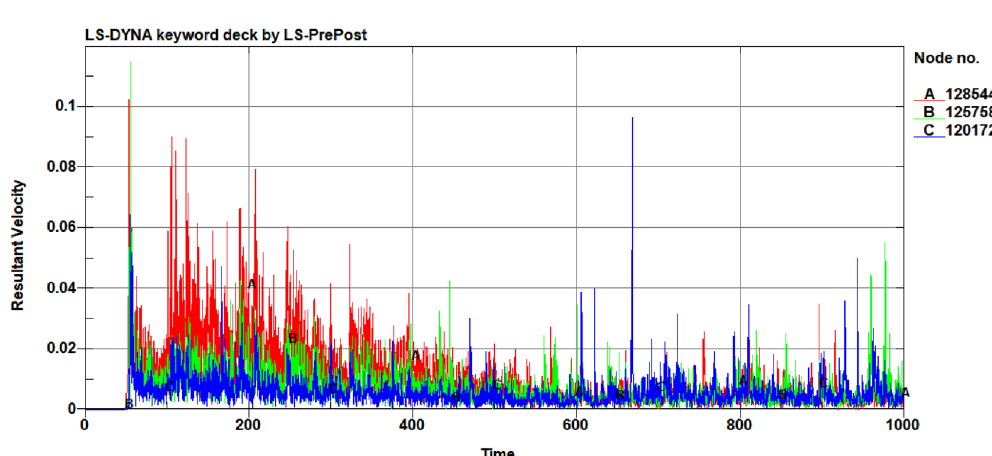
Figure 13. Velocity of soil particle motion at different layer depths.